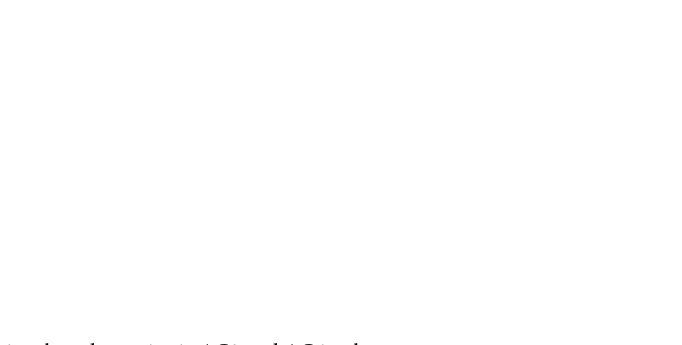
Table 9. Scoring the alternative choices based on criteria AC3 and AC6